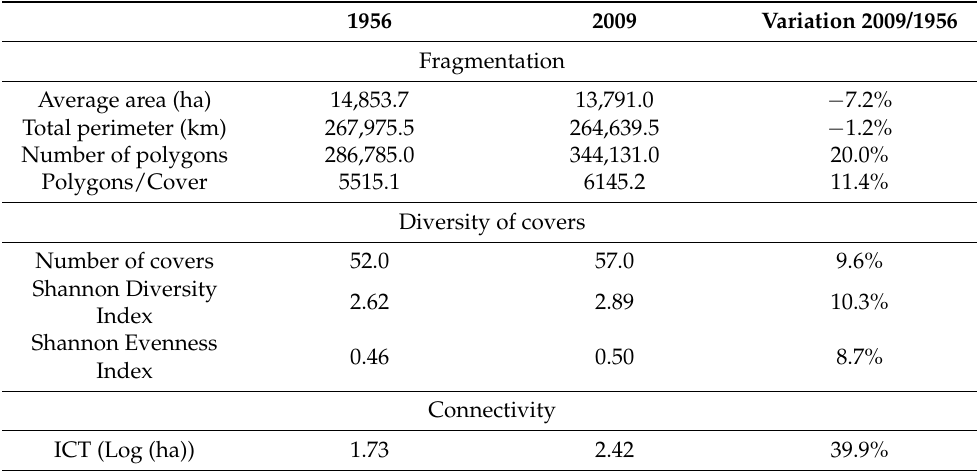
Table 11. Average values of various landscape metrics calculated using the land cover maps of the province of Barcelona in 1956 and 2009 and variation in their average values. Source: Calculations from the MCSC of 2009 and the